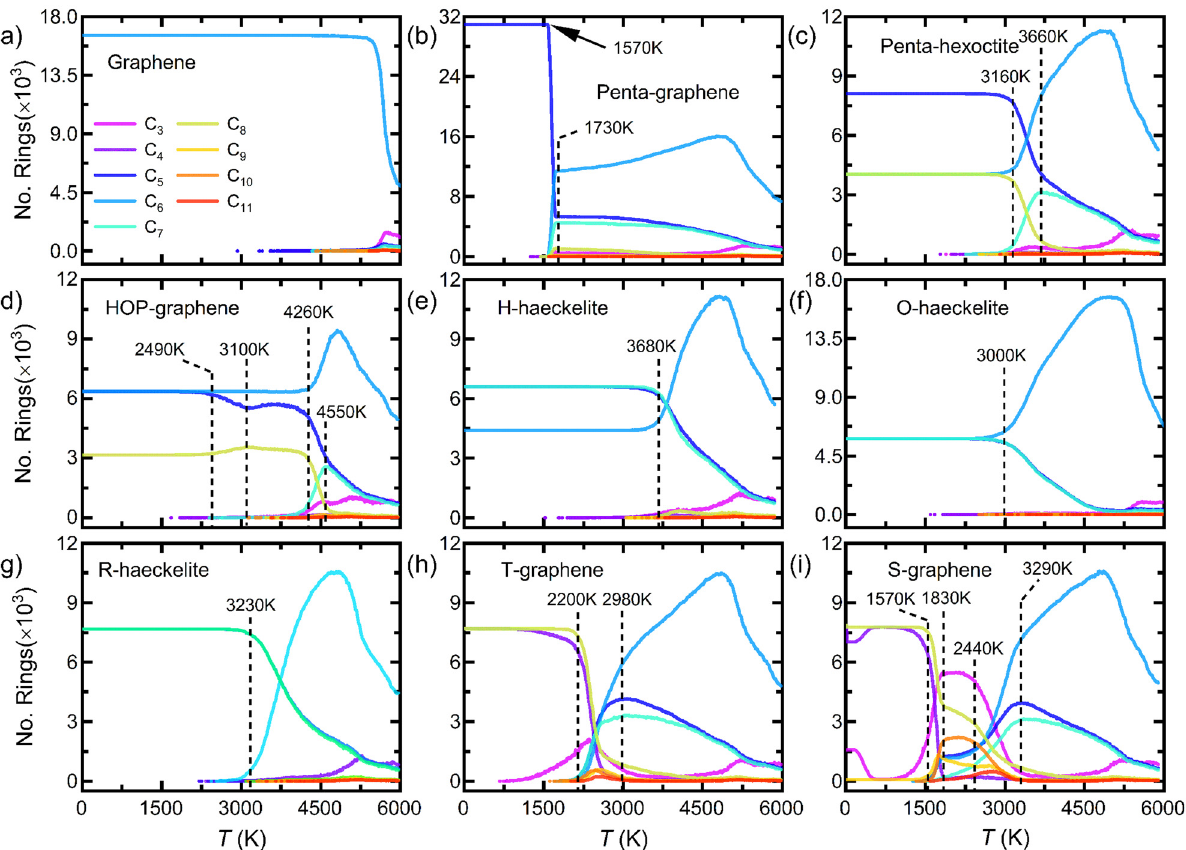
Figure 4: Temperaturedependenceofthenumberofvariouspolygonsin ( a ) graphene, ( b ) penta - graphene, ( c ) penta - hexoctite, ( d ) HOP - graphene, ( e ) H - haeckelite, ( f ) O - haeckelite, ( g ) R - haeckelite, ( h ) T - graphene, and ( i ) S - graphene, respectively. C n ( n = 3, 4 5, … , 11 ) indicates n - membered